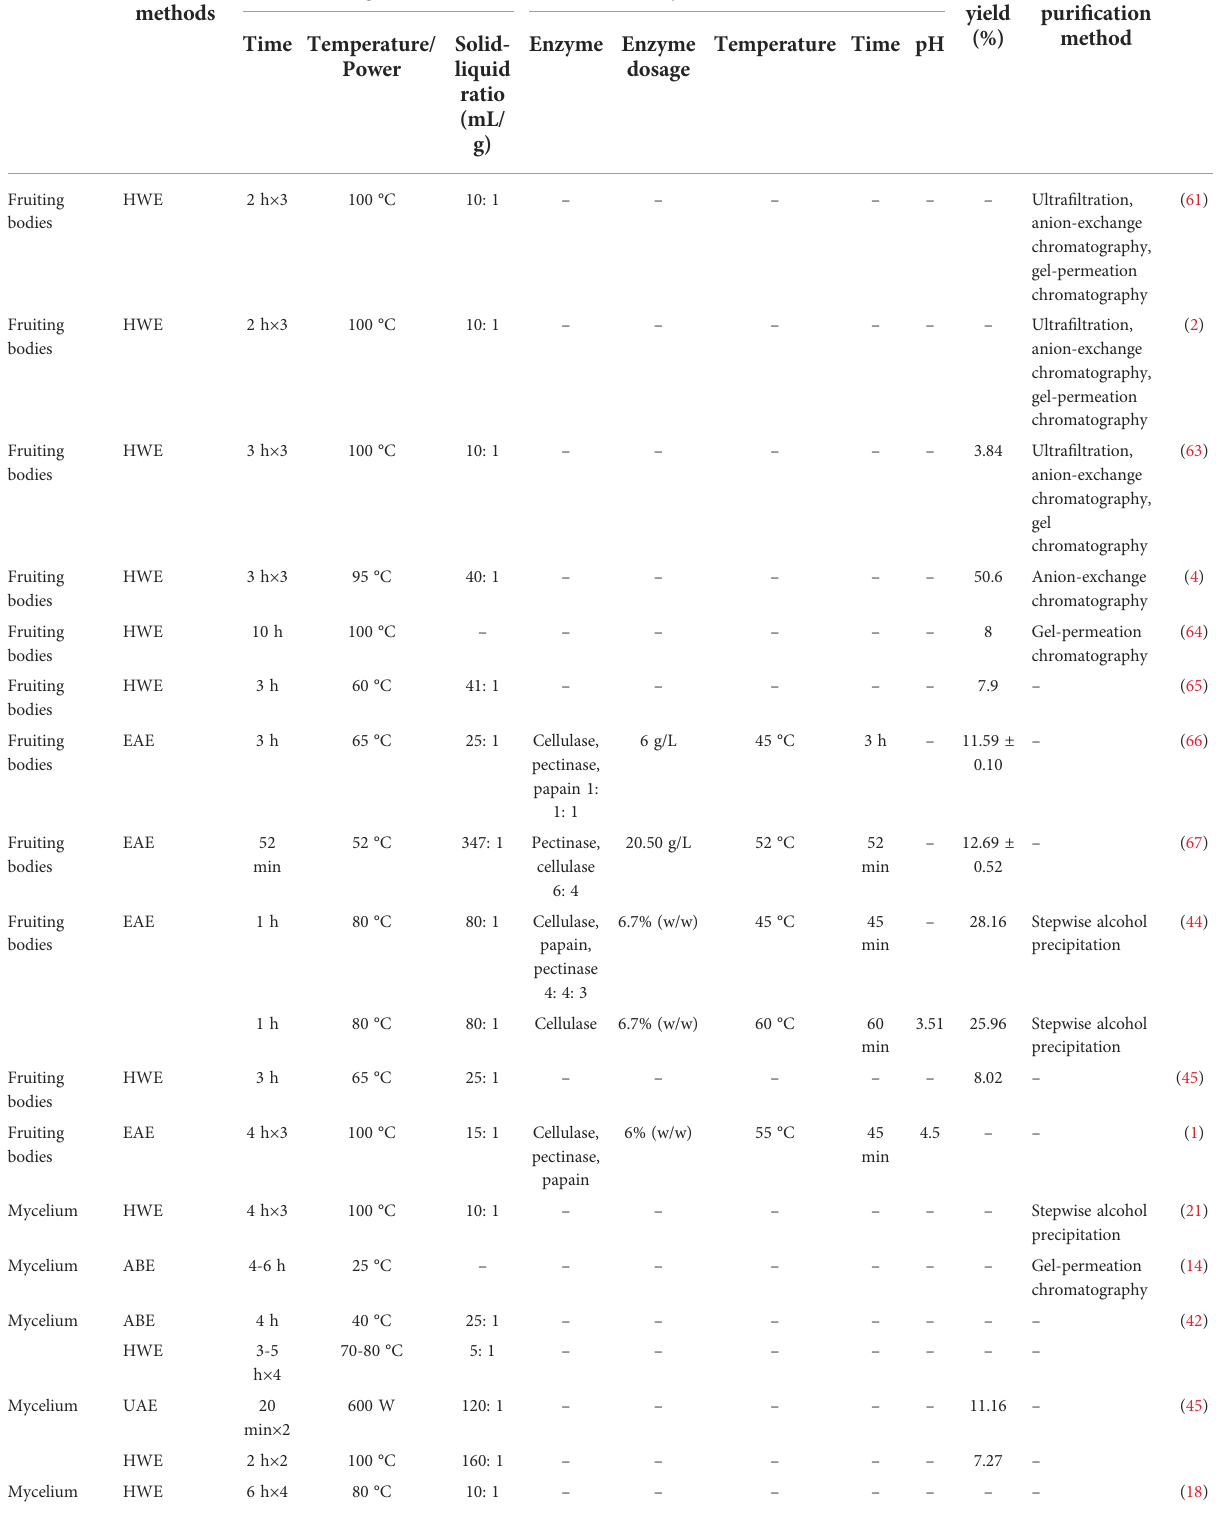
TABLE 1 A summary of the methods of extraction and puri fi cation, conditions and total yield of polysaccharides from T. aurantialba .